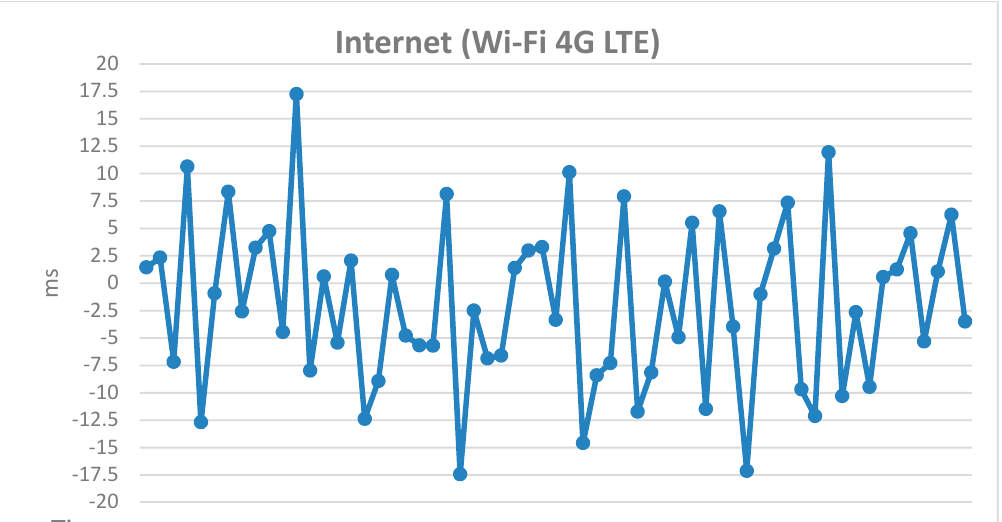
Figure 6. The Network Time Protocol (NTP) synchronization test results.